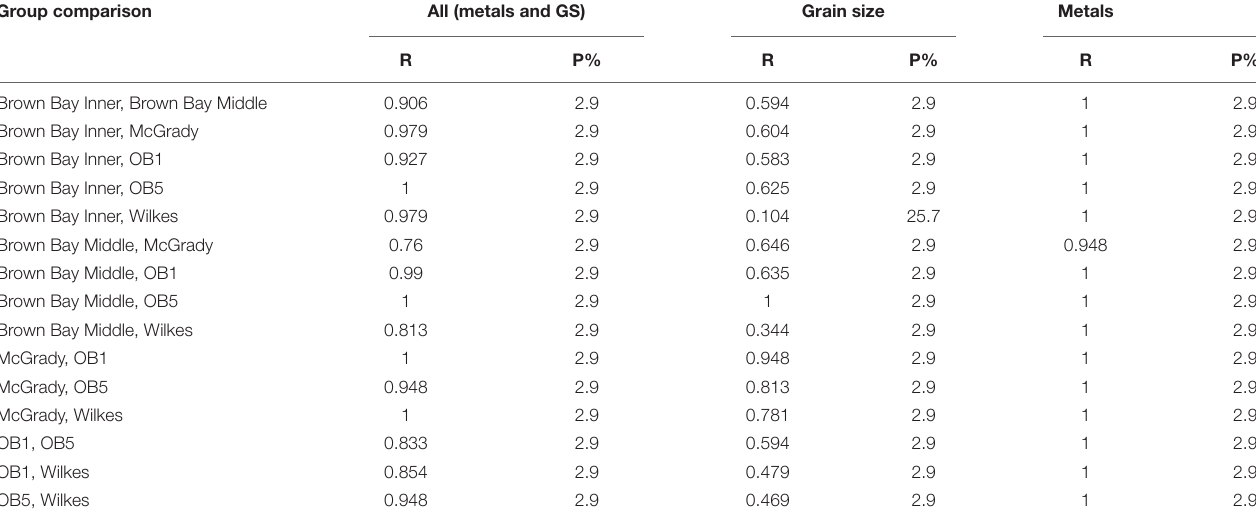
TABLE 7 | ANOSIM results testing for differences among locations for environmental variables. Group comparison All (metals and